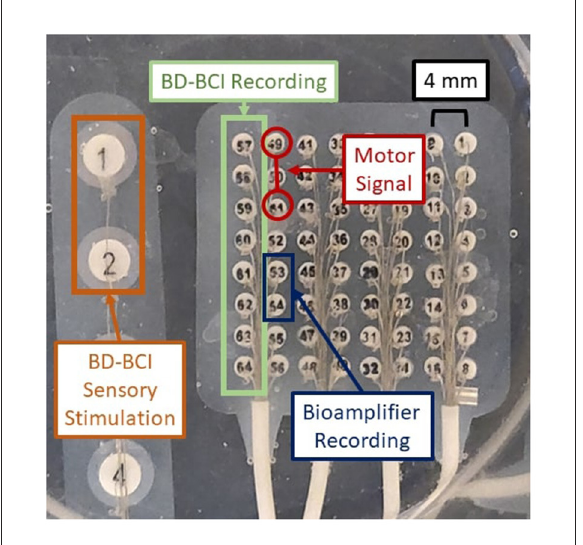
FIGURE4 Experimental setup for BD-BCI operation testing on a brain phantom. Orange: BD-BCI output stimulation during periods of decoded move is applied to electrode 1 and 2 of the ECoG strip on the left. Red: External signal generator output acting as a mock motor signal is applied to electrodes 49 and 51 on the ECoG grid. Blue: Bioamplifier records channel 53 and 54 on the ECoG grid for acquisition purposes. Green: BD-BCI records ECoG channels 57 to 64 for decoding